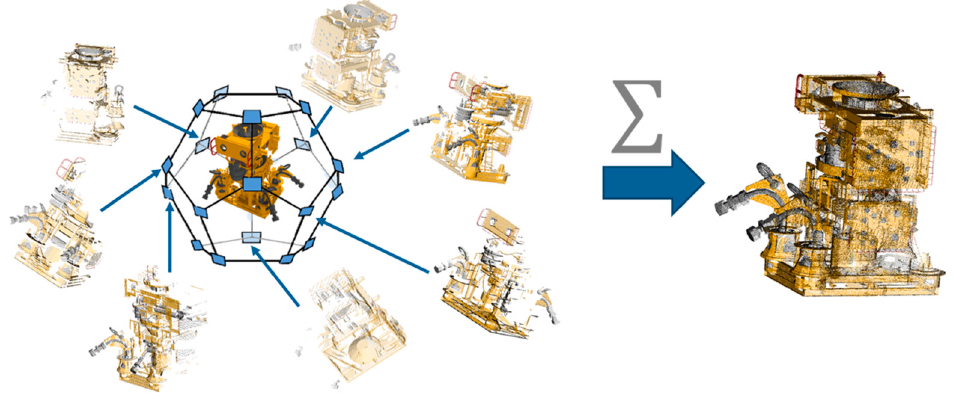
Figure 7. A series of virtual scans are performed, generating a large volume of one-side synthetic